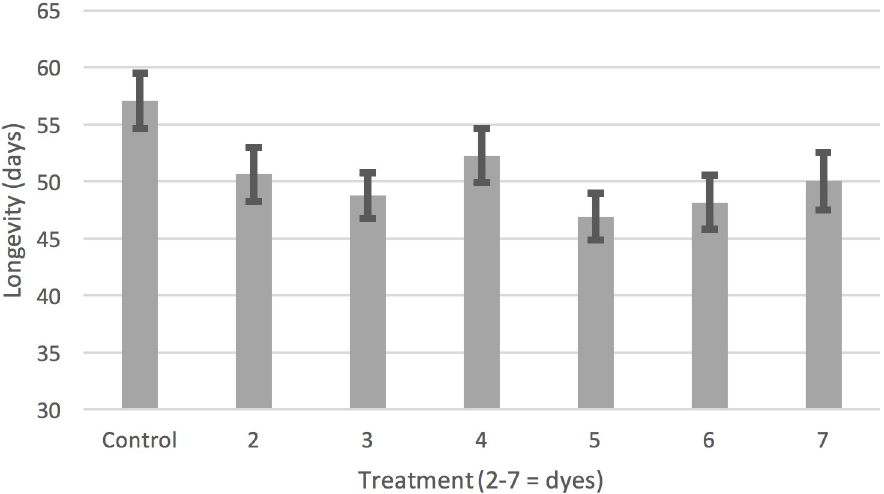
Fig 2. The mean longevity of five populations of D . melanogaster in the control and six different dye treatments. Bars are 95% confidence intervals calculated from a pooled variance estimate by the emmeans R function. Each dye treatment resulted in a significant reduction in mean longevity compared to the control treatment. Treatment 2: SPS Alfachem Blue, 3: Sigma Aldrich, 4: Spectrum Blue, 5: Flavors and Color Blue, 6: Chemistry Connection Blue, 7: Electric Blue.